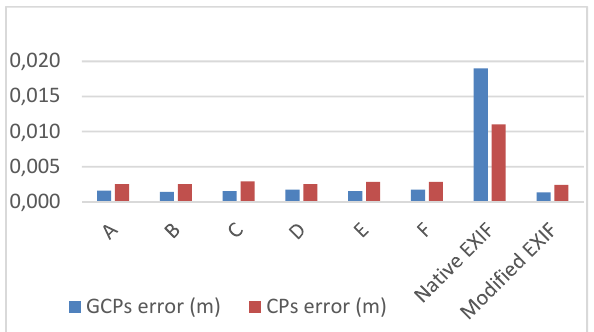
Figure 4. RMSe on GCPs and CPs of the different photogrammetric projects.